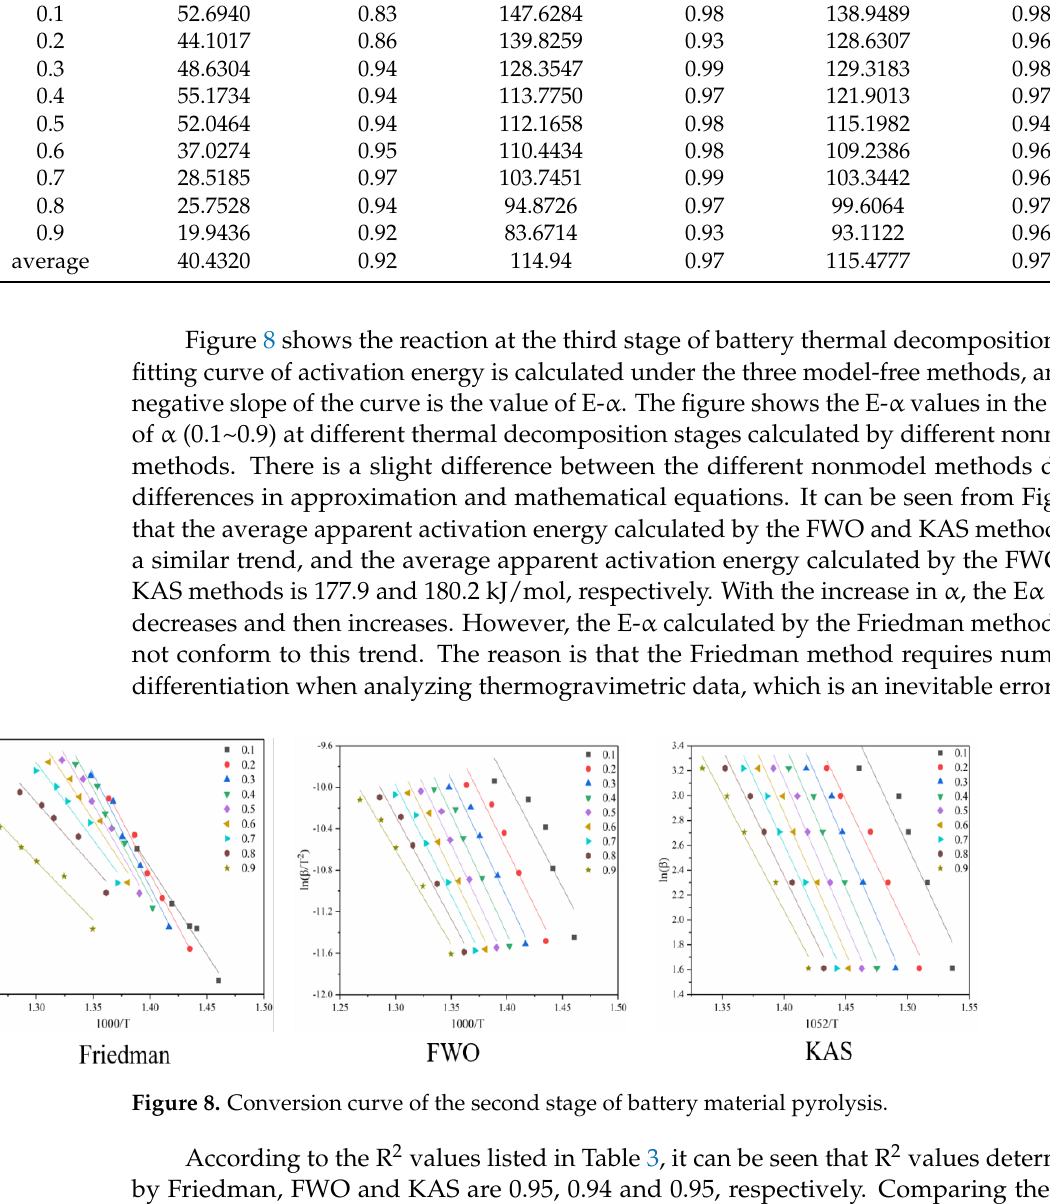
Figure 9. Ea and R 2 of three model-free methods in the second stage of battery material pyrolysis. According to the R 2 values listed in Table 3, it can be seen that R 2 values determined by Friedman, FWO and KAS are 0.95, 0.94 and 0.95, respectively. Comparing the three nonmodel methods, it is found that although the Friedman method has a high degree of fit, it fluctuates greatly, while the dynamics curves determined by the FWO and KAS methods show the same trend and R 2 is very close, showing a good correlation compared with the Friedman method. Table 3. Ea and R 2 of three model-free methods at different conversion rates in the third stage of pyrolysis kinetics of battery materials. Friedman